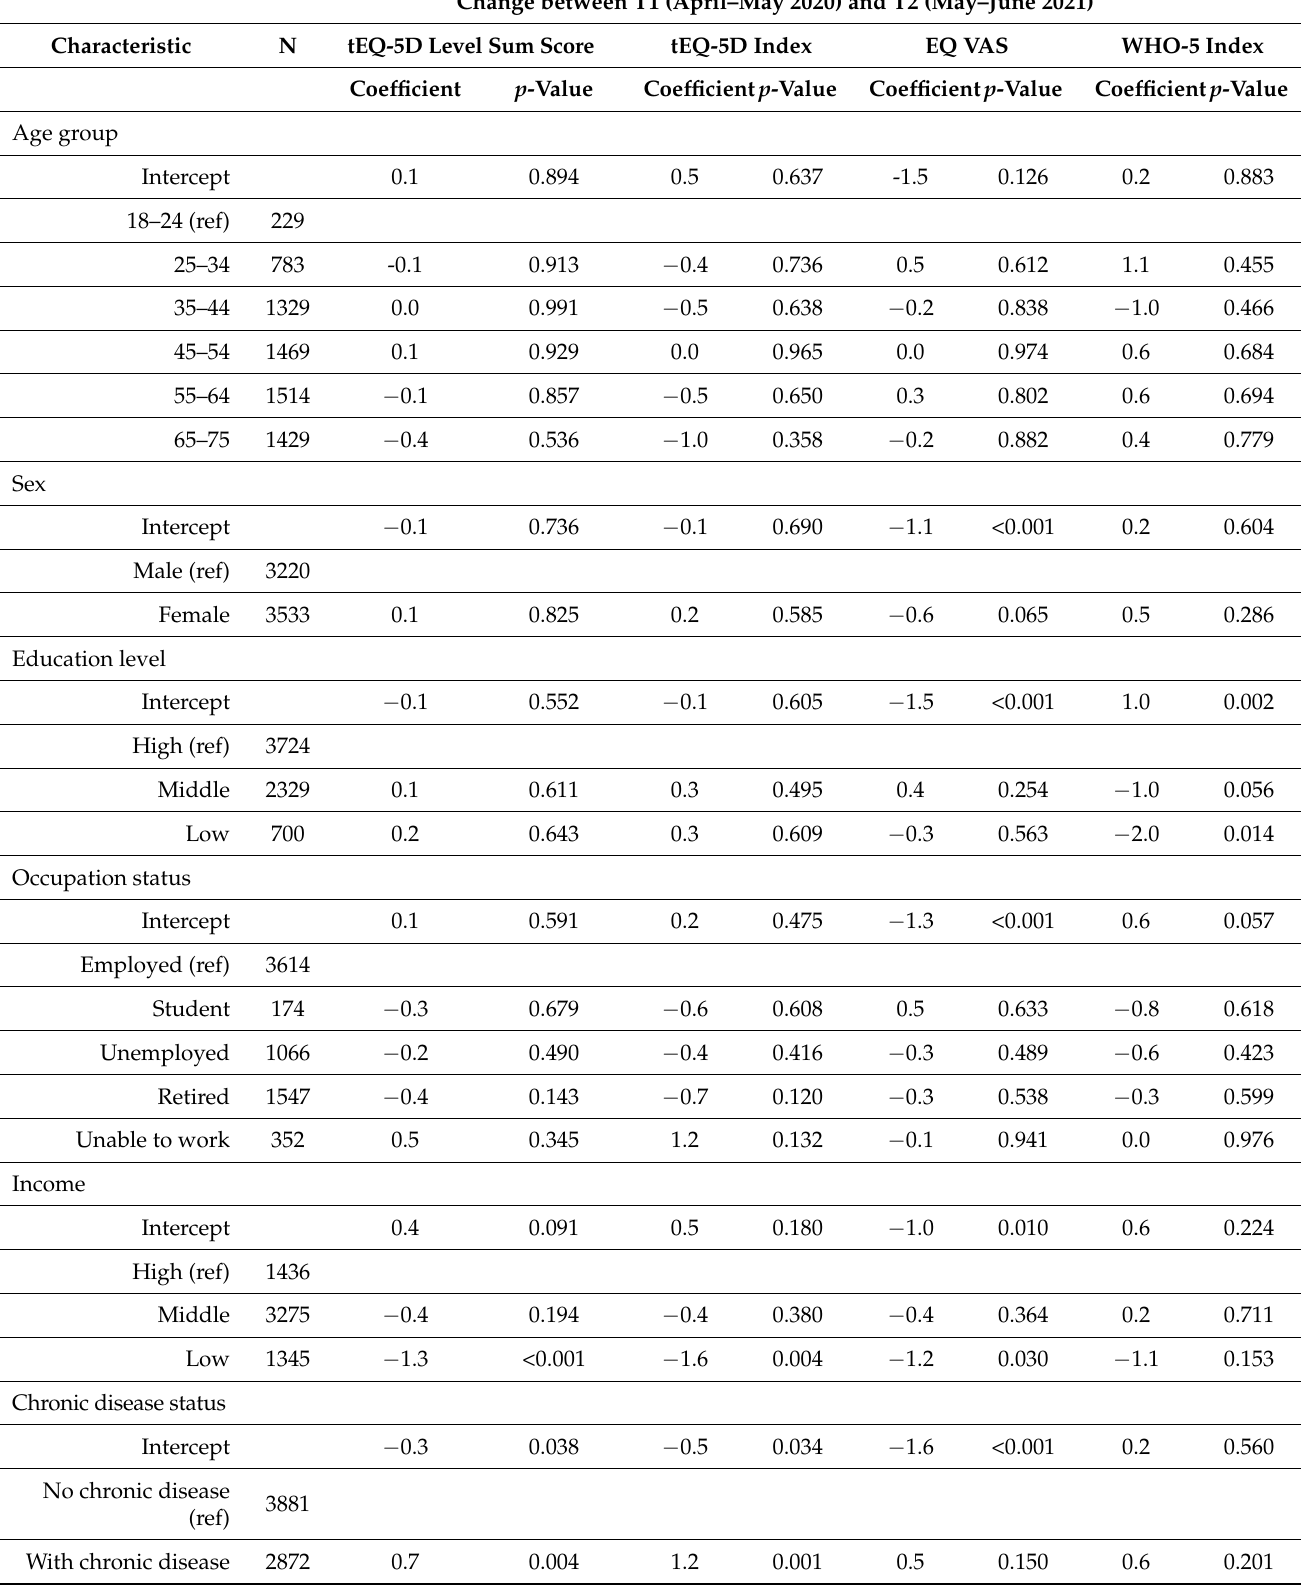
Table 2. Univariate analyses of respondent characteristics and the change in EQ-5D-5L